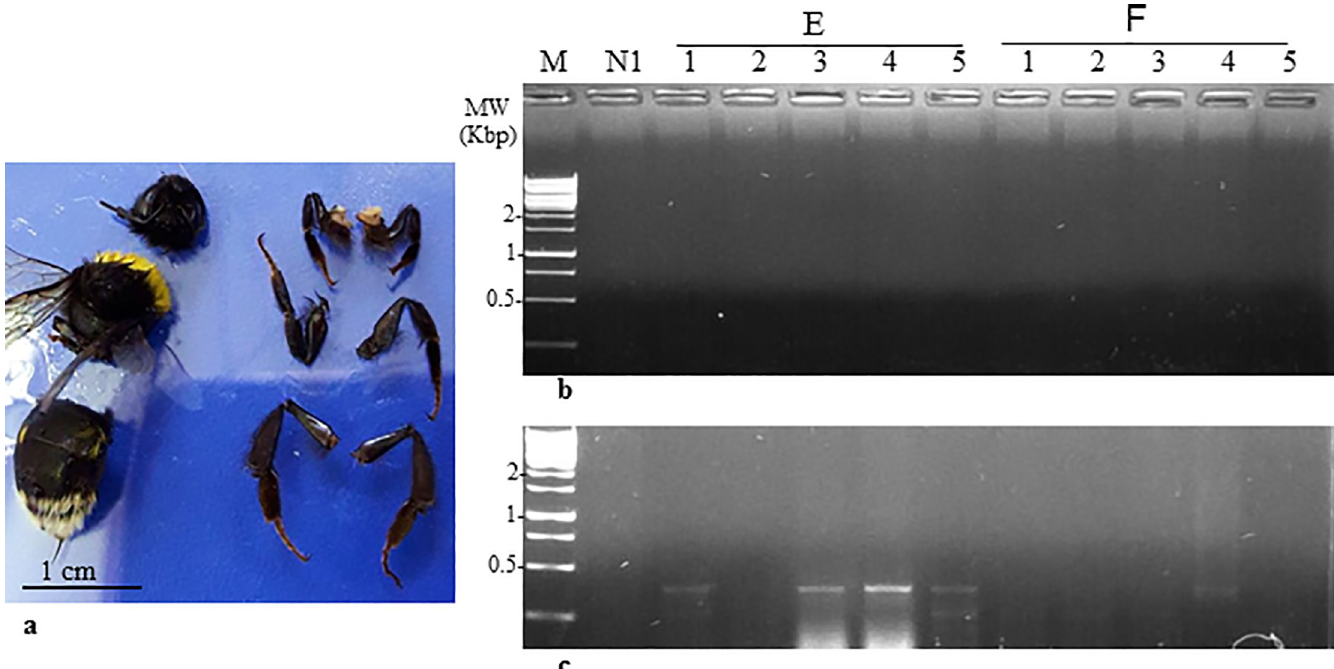
Fig 6. Detection of ToBRFV in dissected bumblebee body parts. a. A dissected bumblebee. b. Negative detection of ToBRFV in dissected bumblebee heads by RT-PCR using F-5,931 and R-6,307 primers. c. Positive detection of ToBRFV in dissected bumblebee abdomens by RT-PCR using F-5,931 and R-6,307 primers. E,F, contaminated bumblebee hives; N, naive bumblebee hive; M, molecular size